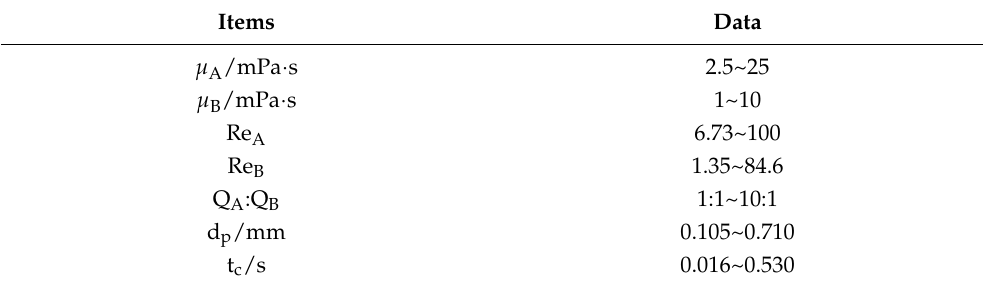
Figure 6. Fitting of liquid–liquid micromixing performance in viscous systems. Black line is the diagonal line that X S ,exp equals to X S ,pre . Red line and blue line correspond to +25% and − 25% deviation of X S ,exp from X S ,pre . Table 2. Fitting range of liquid – liquid micromixing correlation in viscous system.